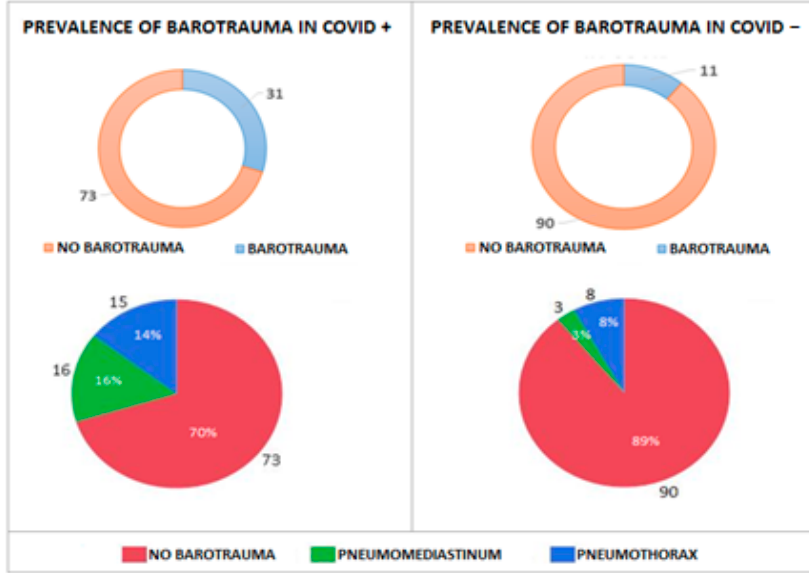
Figure 3. Prevalence of barotrauma in COVID+ patients vs. COVID − patients in ICU.